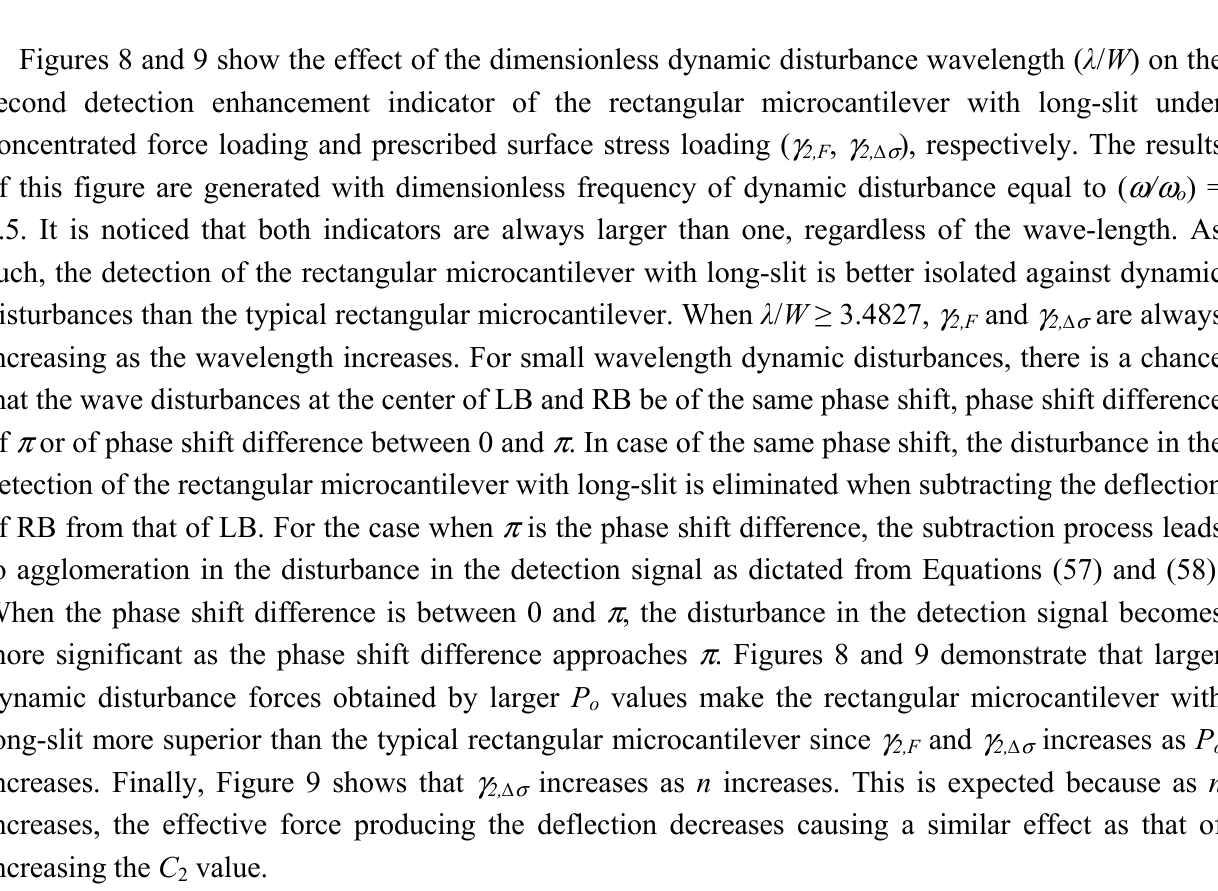
ω 2 / F } on the second detection o o